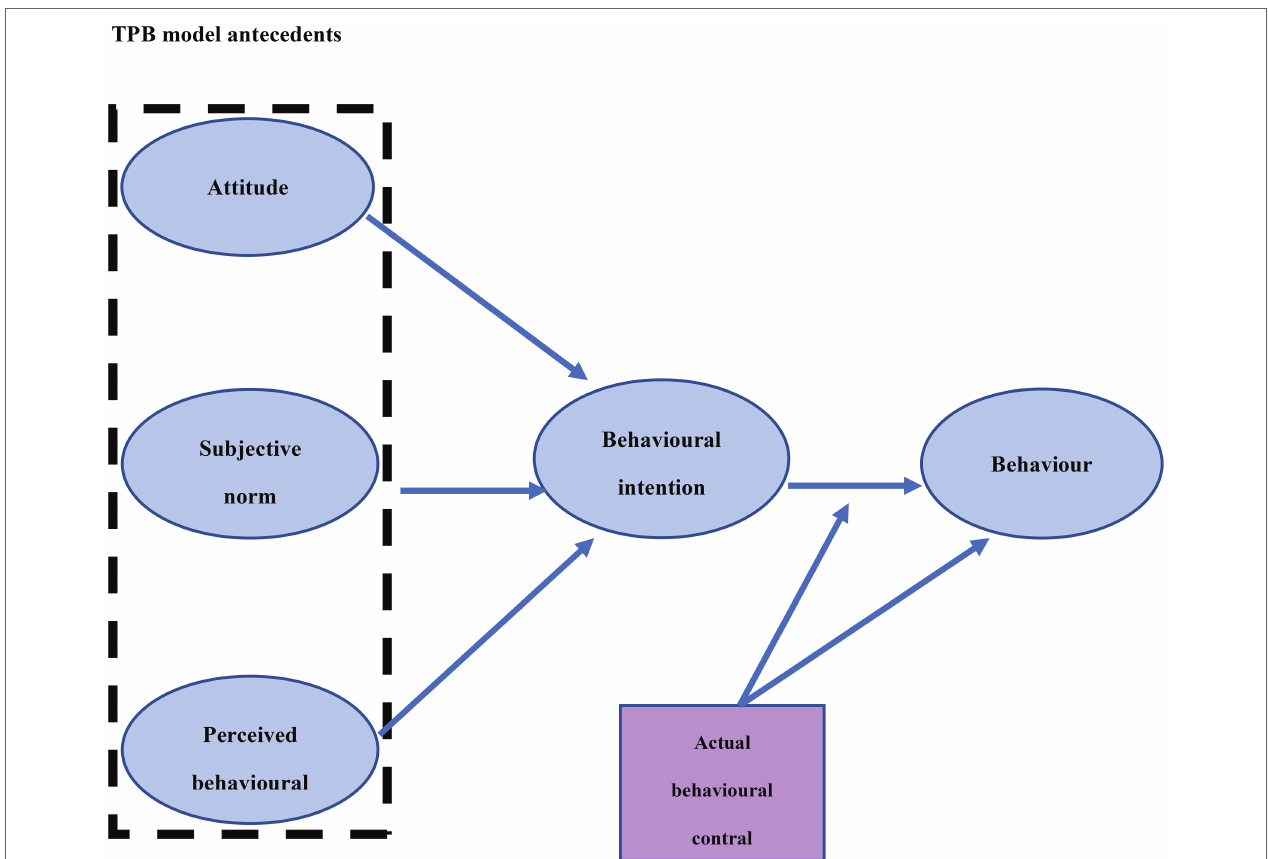
FIGURE 1 | Overview of the theory of planned